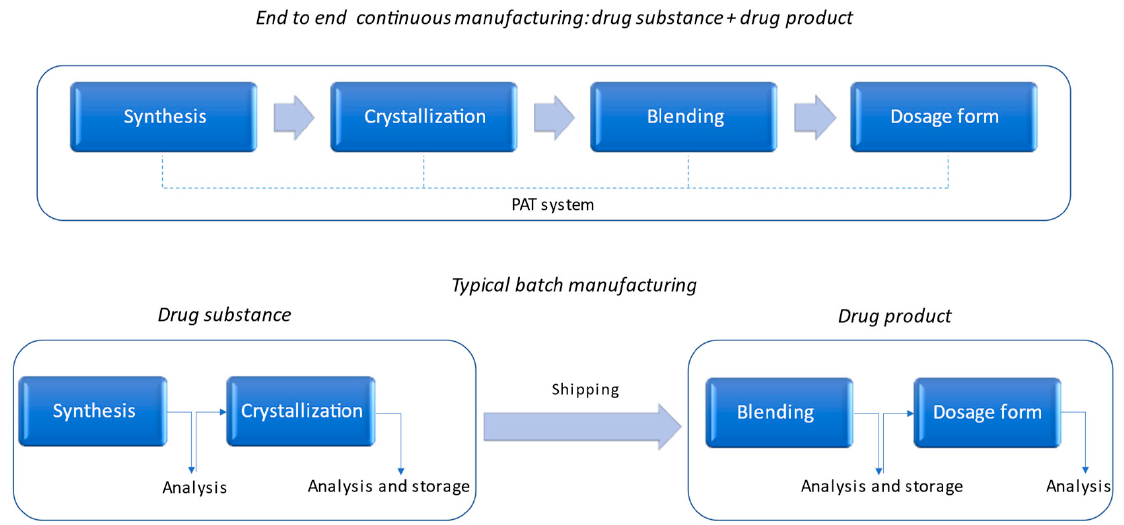
Figure 1. End-to-end continuous manufacturing compared to batch-manufacturing process.